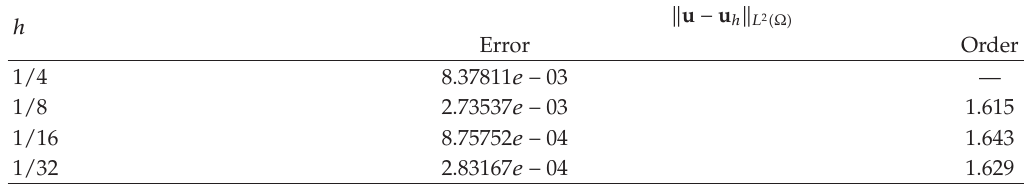
Table 1: L 2 -error and order of convergence in x when μ (cid:8) 1 .